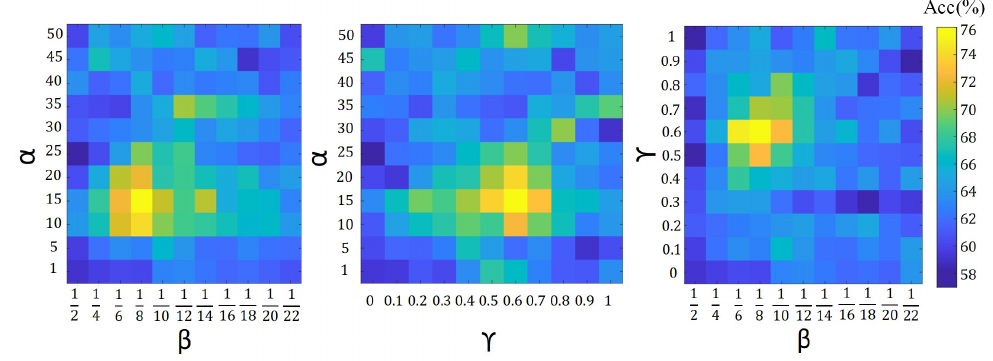
Figure 6. Validation accuracy of DPPMI dropout with different configurations of defined hyper- parameters in (20) and